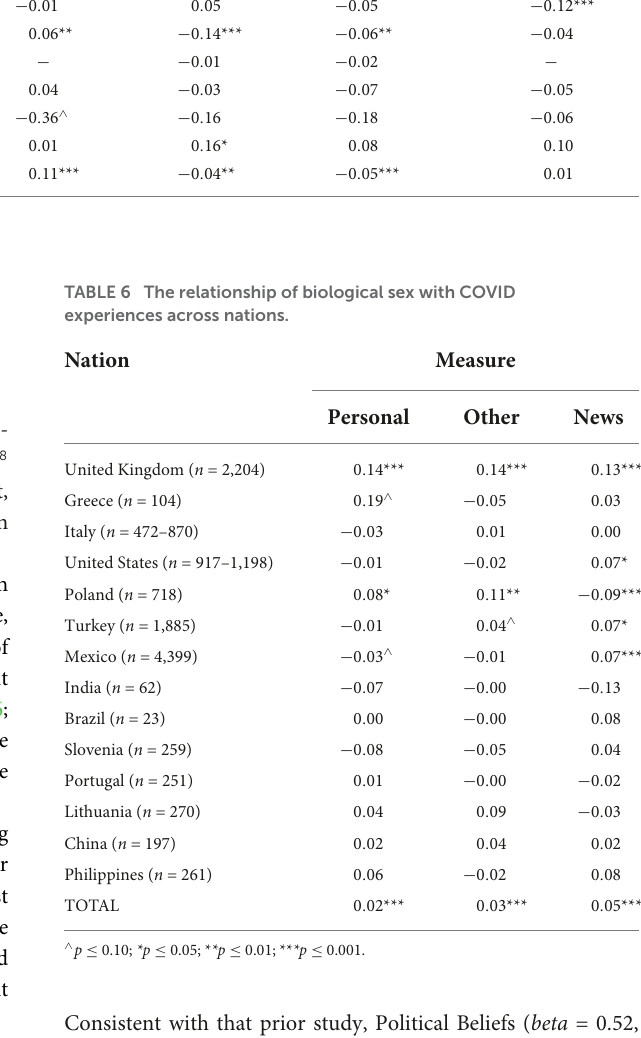
TABLE 5 The relationship of biological sex with government response across nations. Nation Measure Restriction Punish Reactance Research Stimulus Contamination United King. ( n = 2,204)